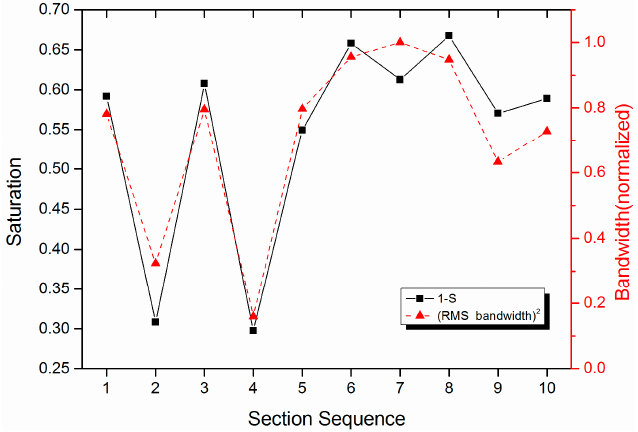
Figure 6. Comparison of waveforms between parameters S and the (RMS bandwidth) 2 of the UHF-B frequency spectrum.